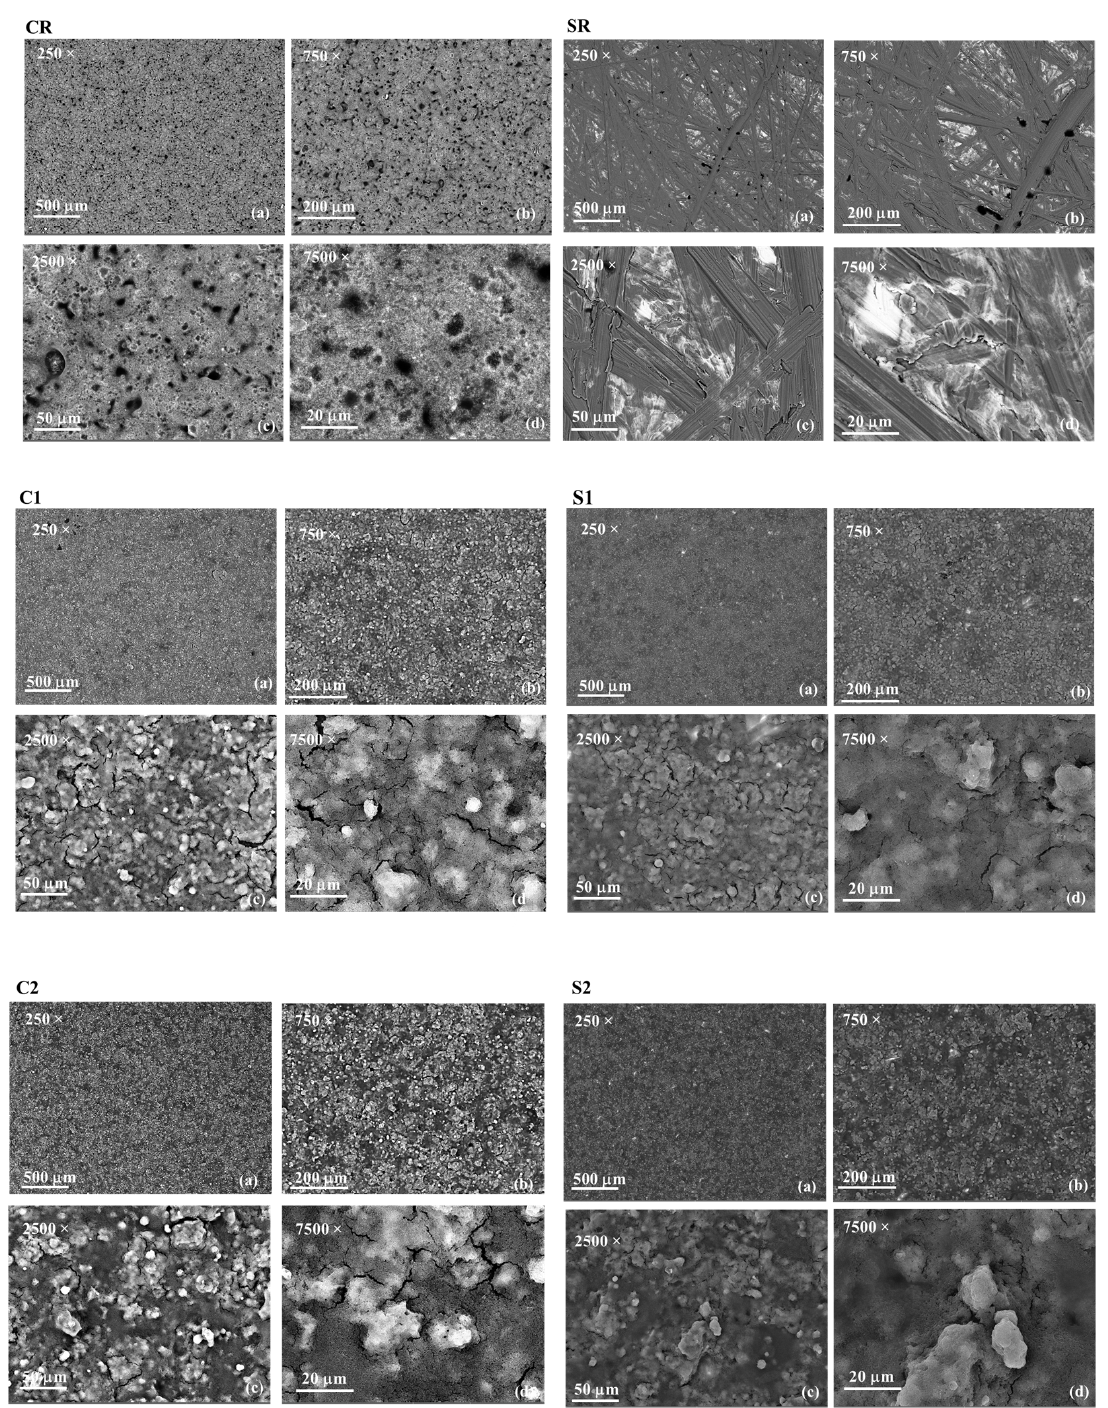
Figure 5. Top View of SEM images at 250× ( a ), 750× ( b ), 2500× ( c ), and 7500× ( d ) of CR, SR, C1, S1, C2, and S2 samples.